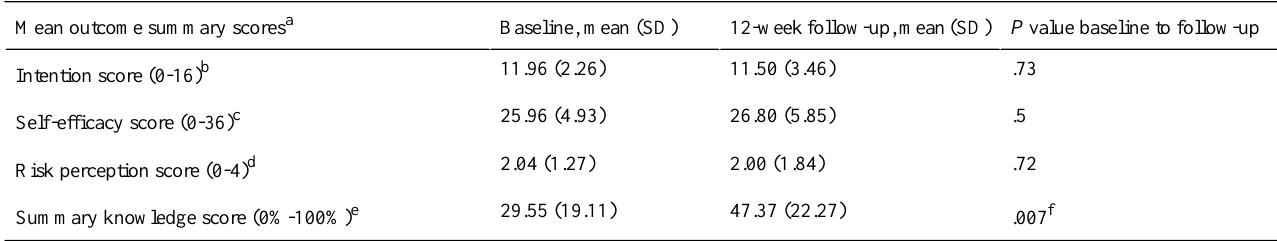
Table 3. Condom-specific questions—summary scores before and at 12-week follow-up.